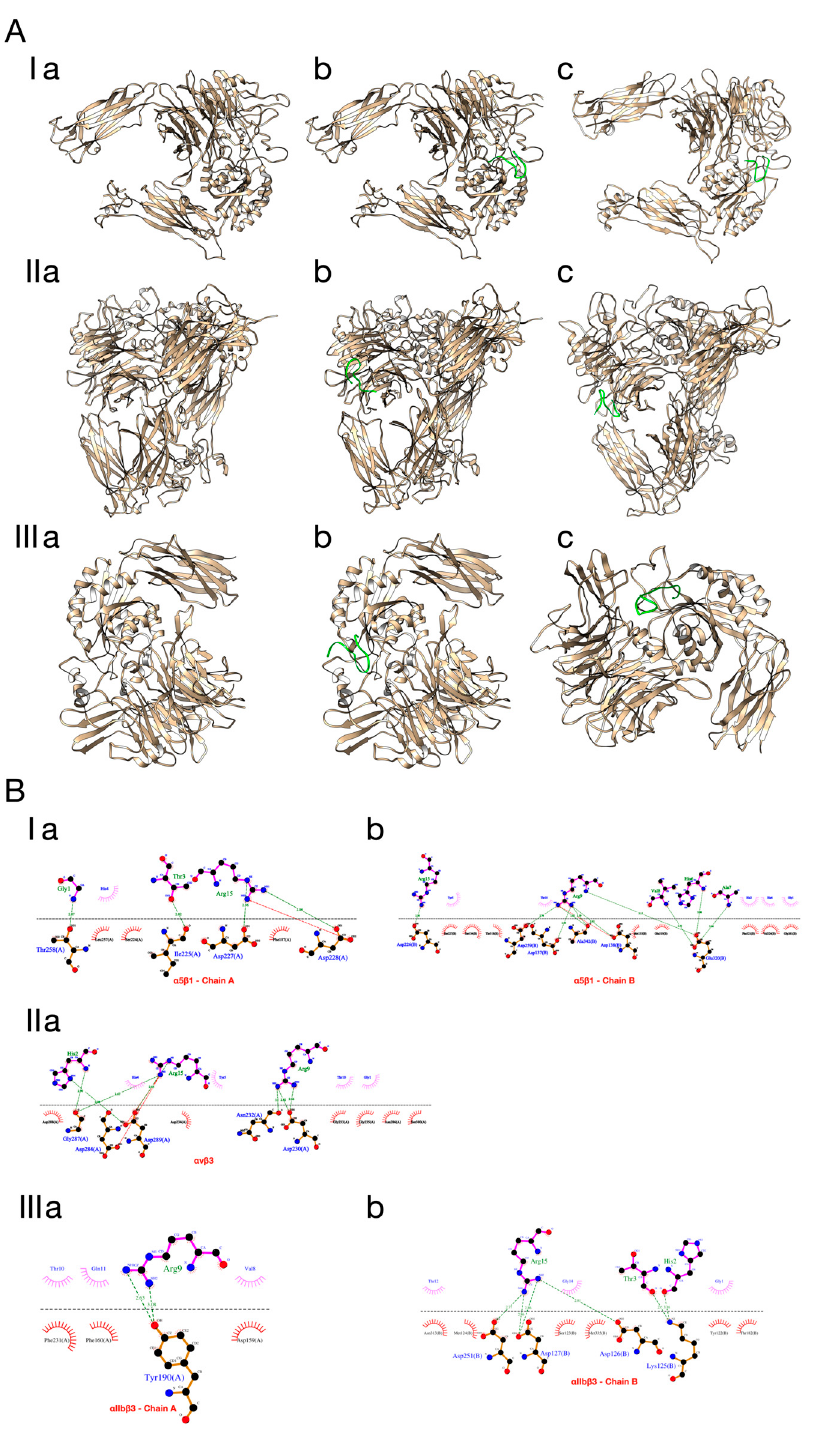
Figure 2. A ( I ) α 5 β 1 alone ( a ), and in complex with peptide 1 after docking ( b ) and dynamics simulations ( c ); A ( II ) α v β 3 alone ( a ), and in complex with peptide 1 after docking ( b ) and dynamics simulations ( c ); A ( III ) α IIb β 3 alone ( a ), and in complex with peptide 1 after docking ( b ) and dynamics simulations ( c ); ( B ) LIGPLOTS of the binding interactions between peptide 1 and the integrins α 5 β 1 ( I ), α v β 3 ( II ), and α IIb β 3 ( III ). In the LIGPLOTS, peptide 1 is above the dotted line, while integrins are below. The arcs with red spines represent hydrophobic interactions, while the green dotted lines indicate hydrogen bonds.